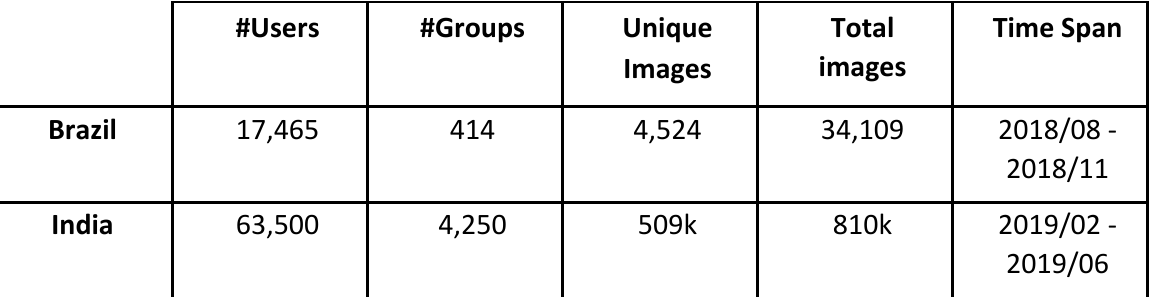
Table 2. Statistics of our WhatsApp